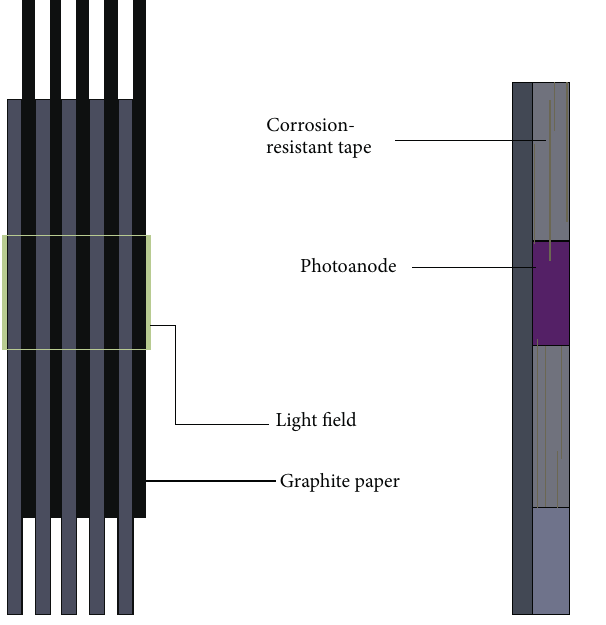
Figure 1: Schematic diagram of vertical DSSC assembly.